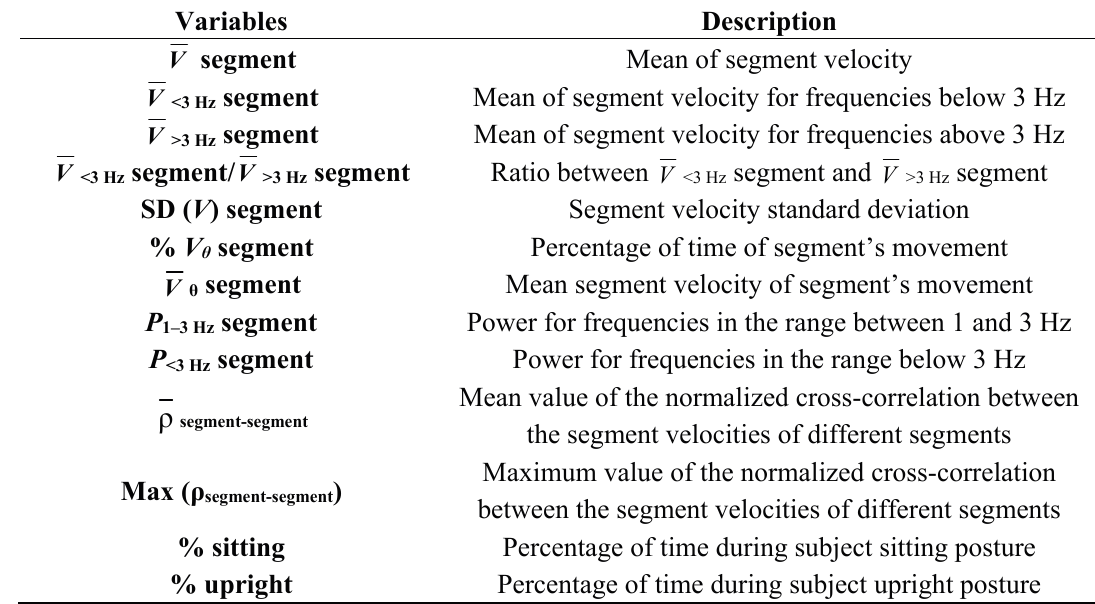
Table 3. List of input parameters for neural network